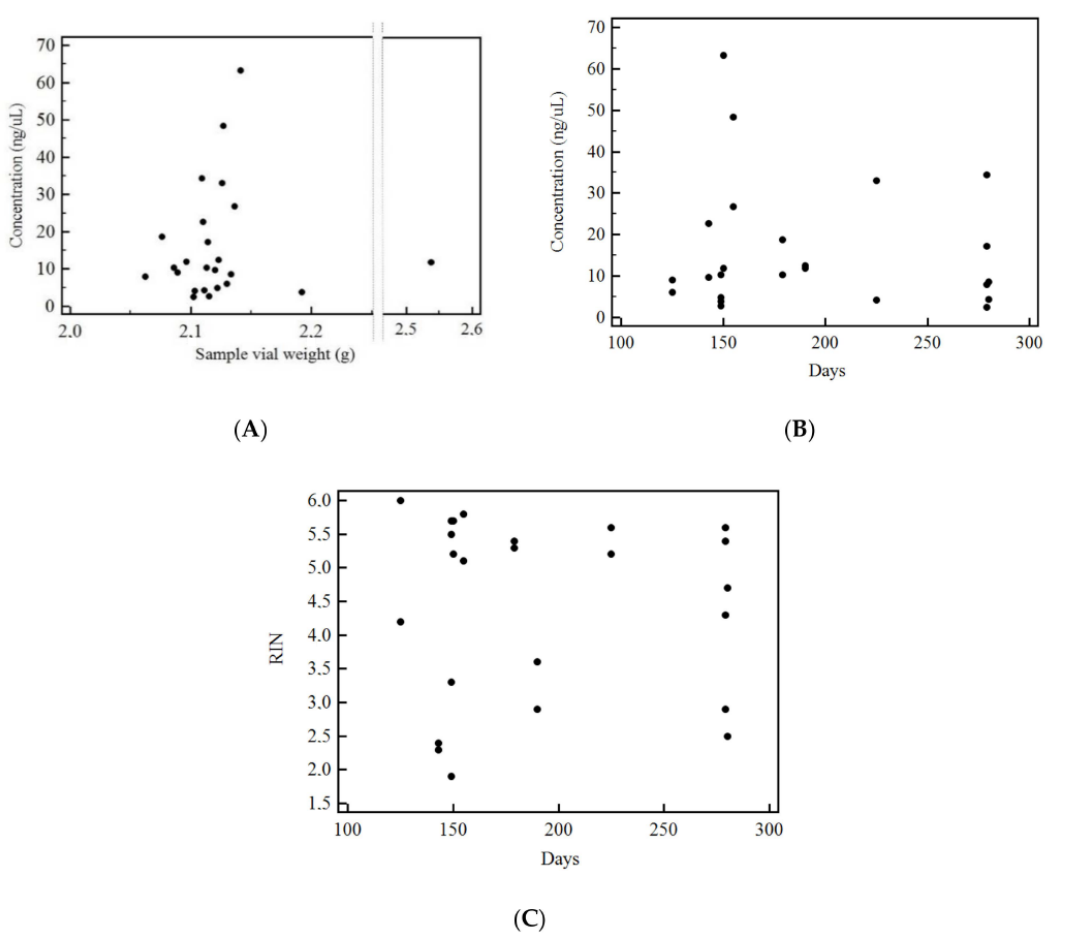
Figure 3. Correlation analyses showing no significance between the final RNA concentration and the weight of the initial sample vial ( A ) (Kendall’s Tau = 0.13, p = 0.39) or the time elapsed from sampling to RNA extraction ( B ) (Kendall’s Tau = 0.03, p = 0.84) or RNA integrity and time elapsed from sampling to RNA extraction ( C ) (Kendall’s Tau = 0.04, p =